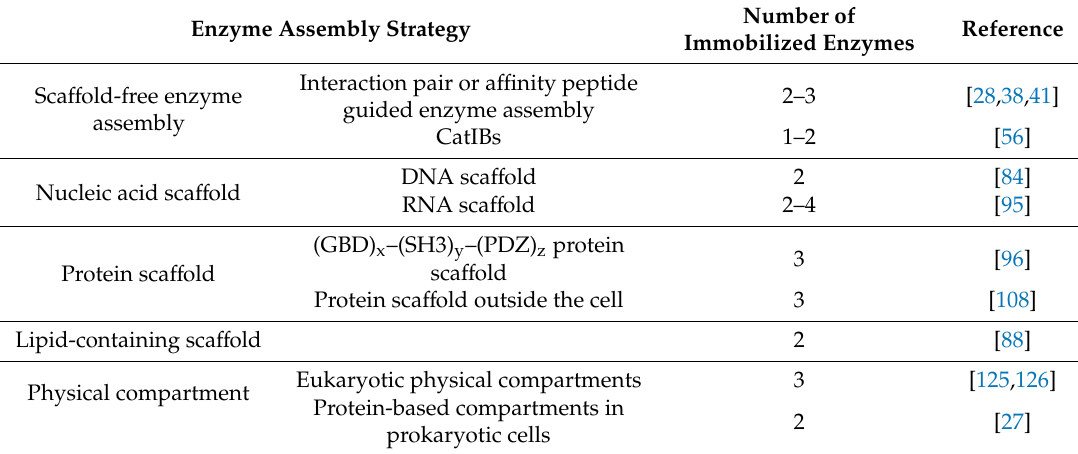
Table 1. Application of di ff erent enzyme assembly strategies in